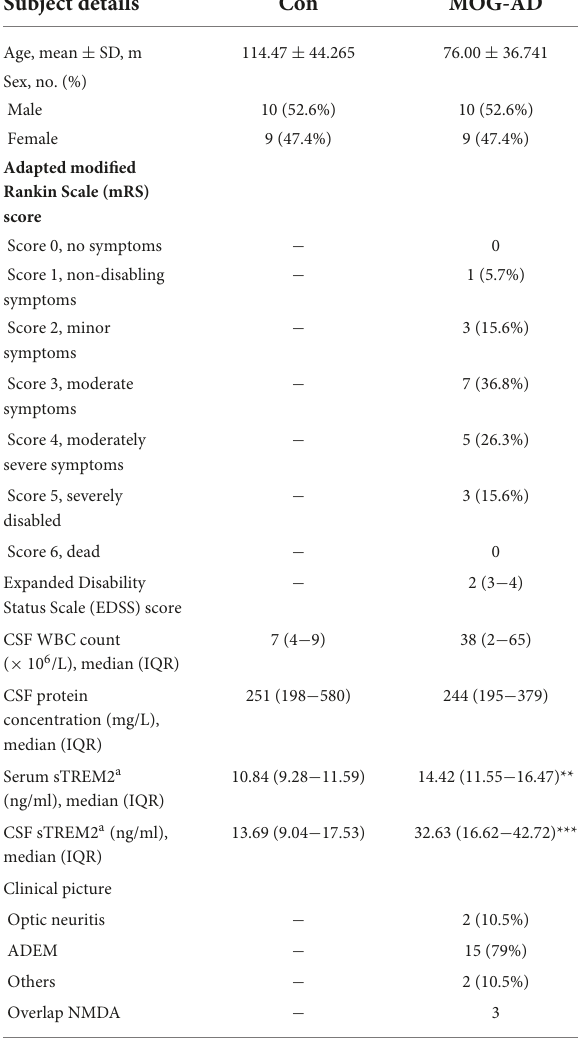
TABLE 1 Clinical and demographic characteristics of